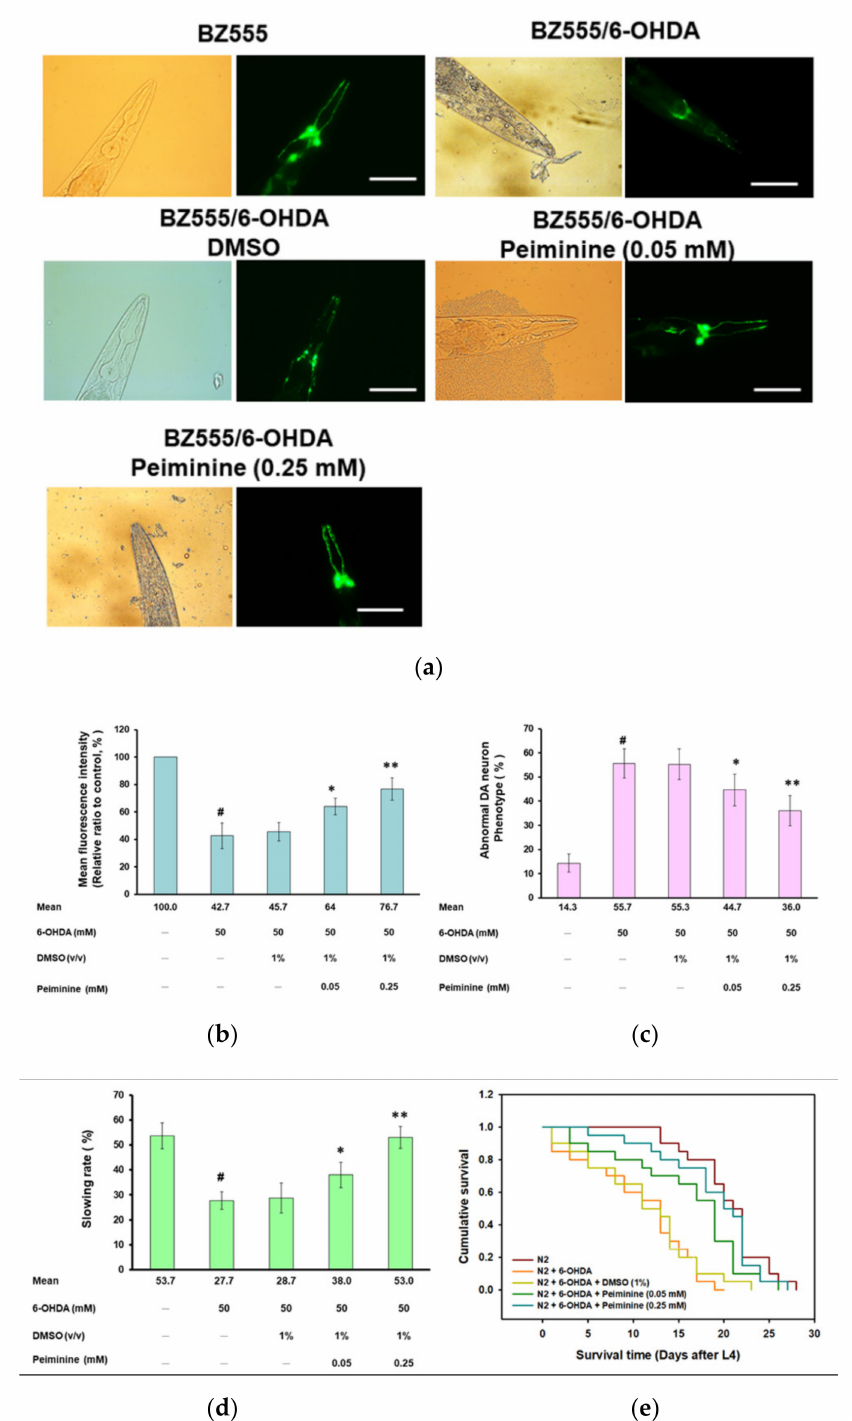
Figure 3. Dopaminergic (DA) neurons degeneration, food-sensing behavior defects, and shortened lifespan of worms caused by 6-hydroxydopamine (6-OHDA) are improved by peiminine (PMN) pretreatment. L1 stage worms were transferred to OP50/NGM plates with or without PMN and grown to the L3 stage, exposed to 6-OHDA for 1 h, and then transferred to OP50/NGM/FUDR plates with or without PMN and cultured for another 3 days before analysis. ( a ) Representative fluorescence images of GFP expression patterns in head DA neurons of BZ555 worms in each group. Scale bar = 50 µ m. ( b ) The fluorescence intensity of the GFP image of each group was quantified in ( a ) using ImageJ software. ( c ) The DA neuron degeneration phenotype defects of each group in ( a